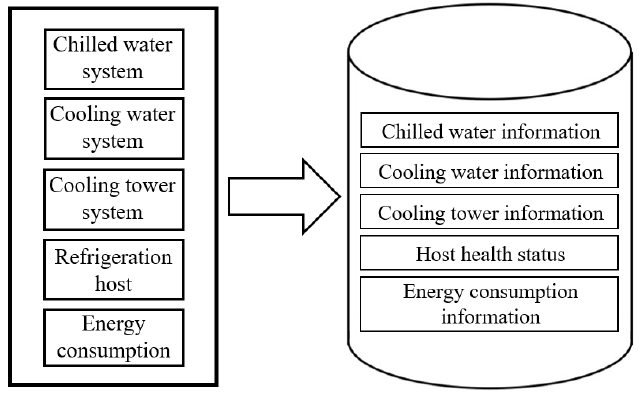
Figure 2. Building information and data source.